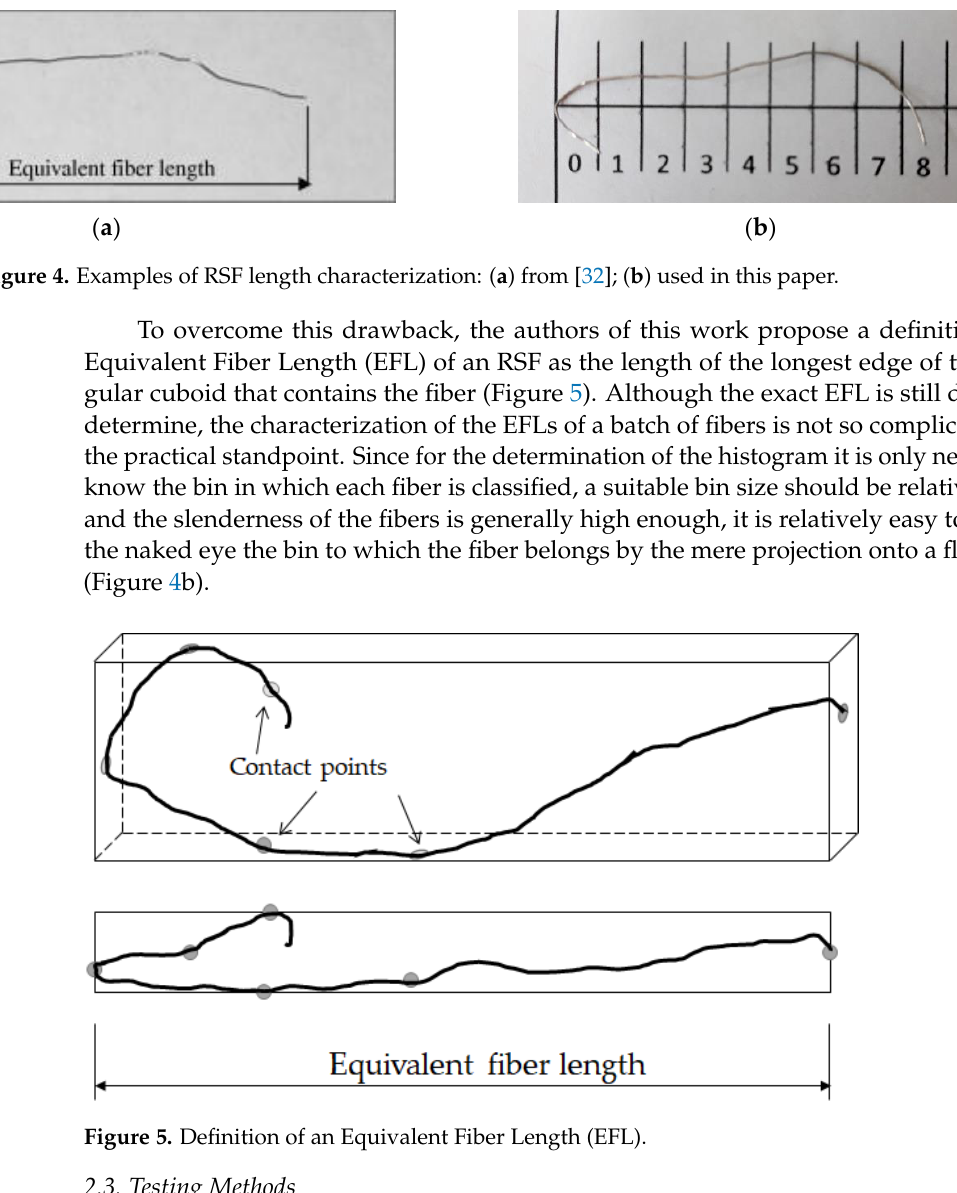
Figure 5. Definition of an Equivalent Fiber Length